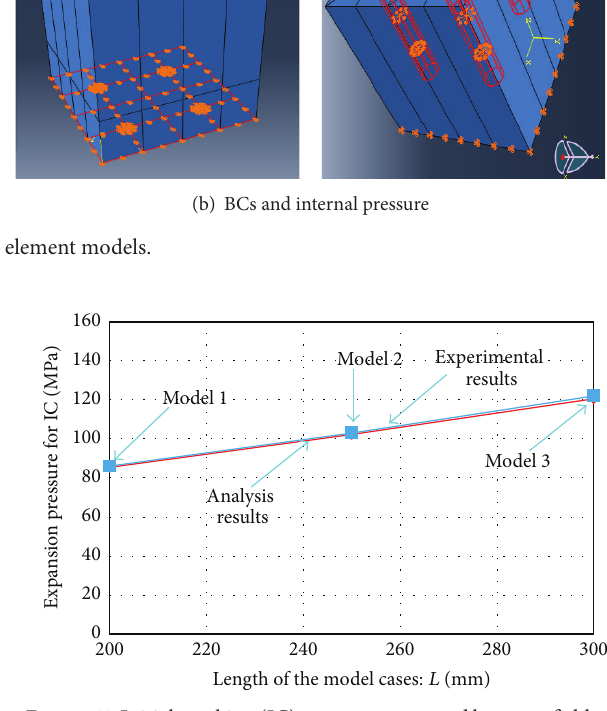
Figure 11: Initial cracking (IC) pressure compared between field test results and FE analysis